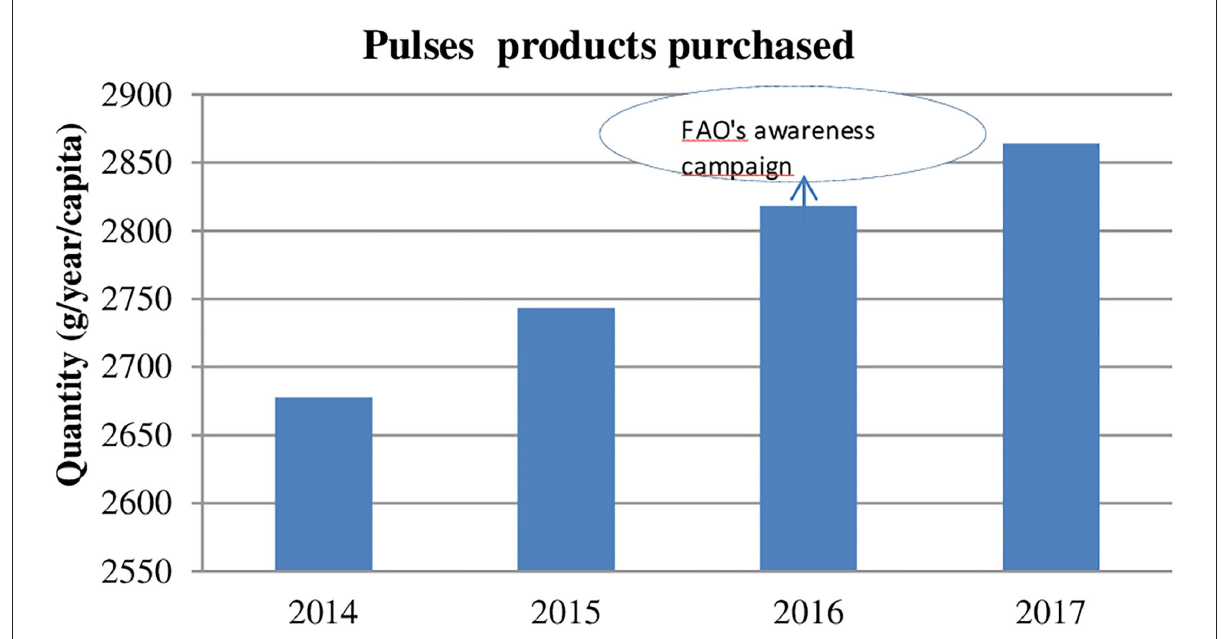
FIGURE1 Evolution of purchased quantity of pulses products (g/year/cap), 2014–2017. Source: Kantar Worldpanel 2014–2017.